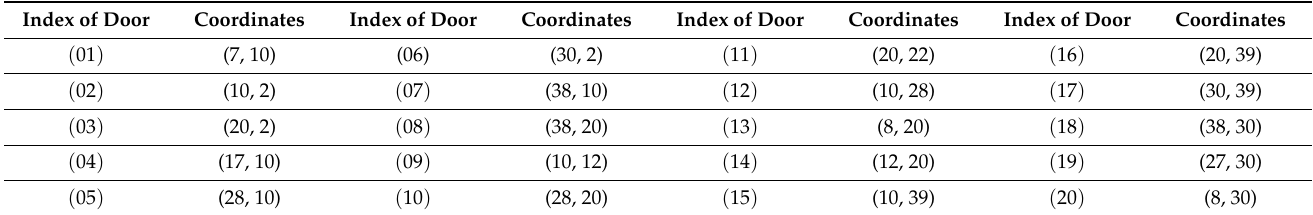
Figure 7. Service space of Simulation.